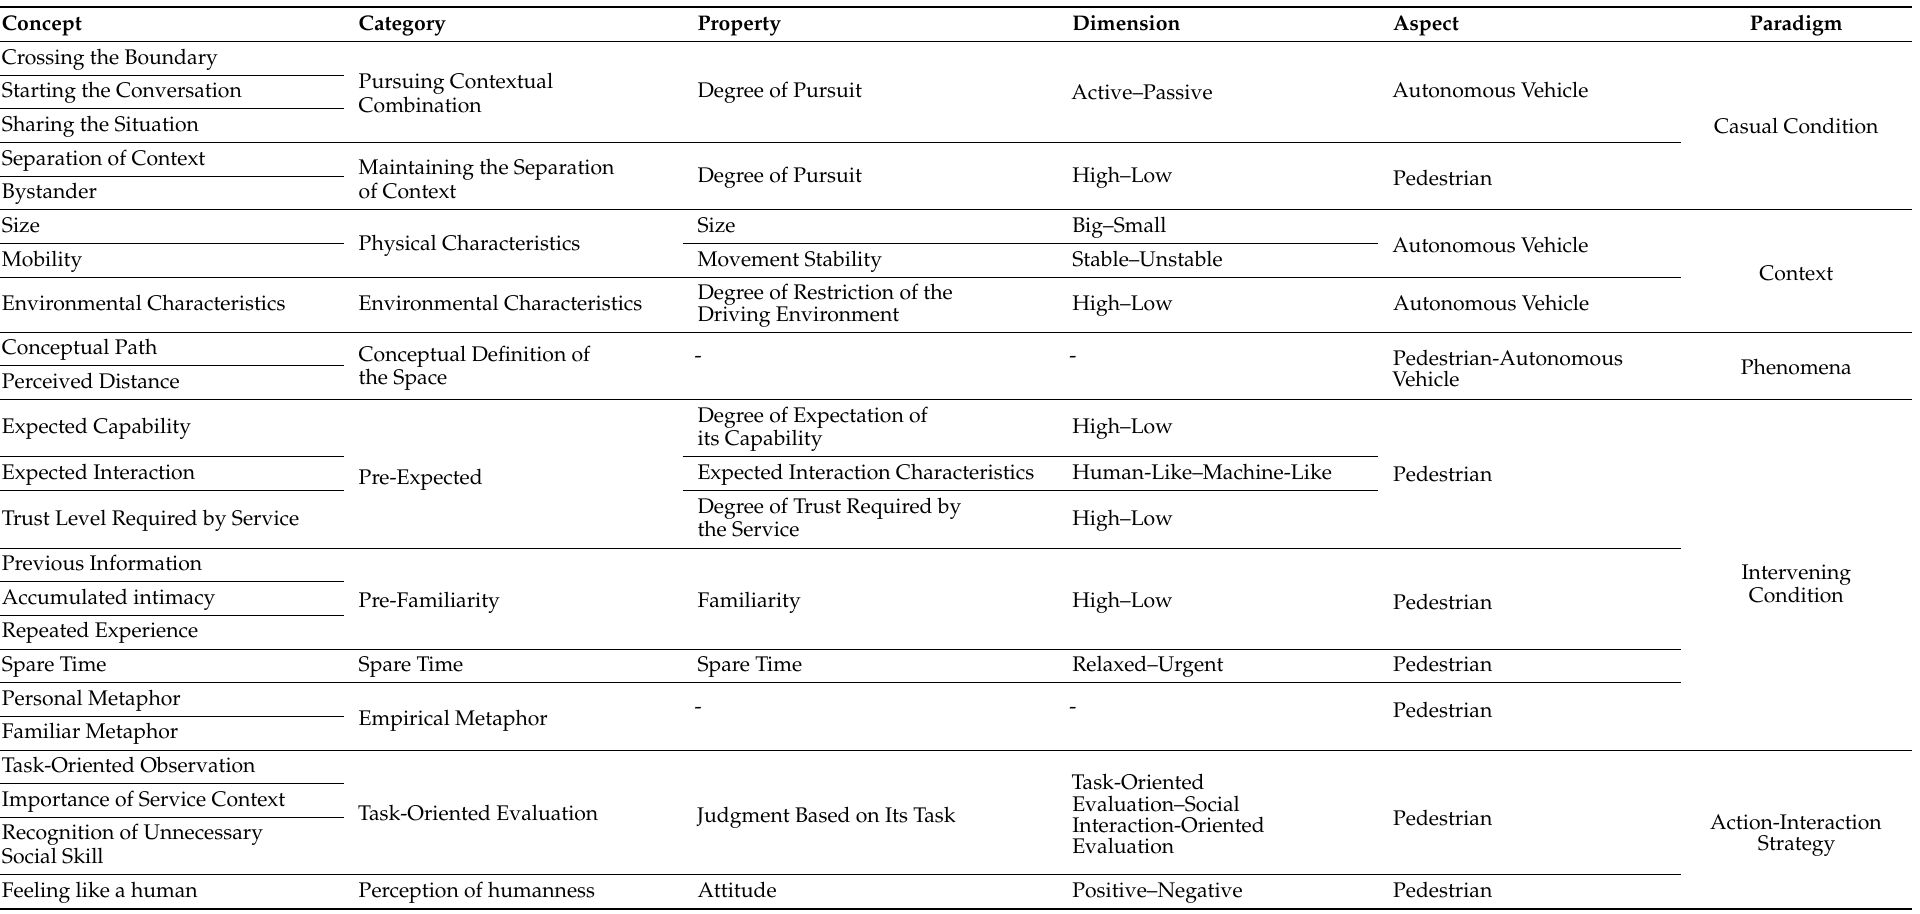
Table 6. Results of Qualitative